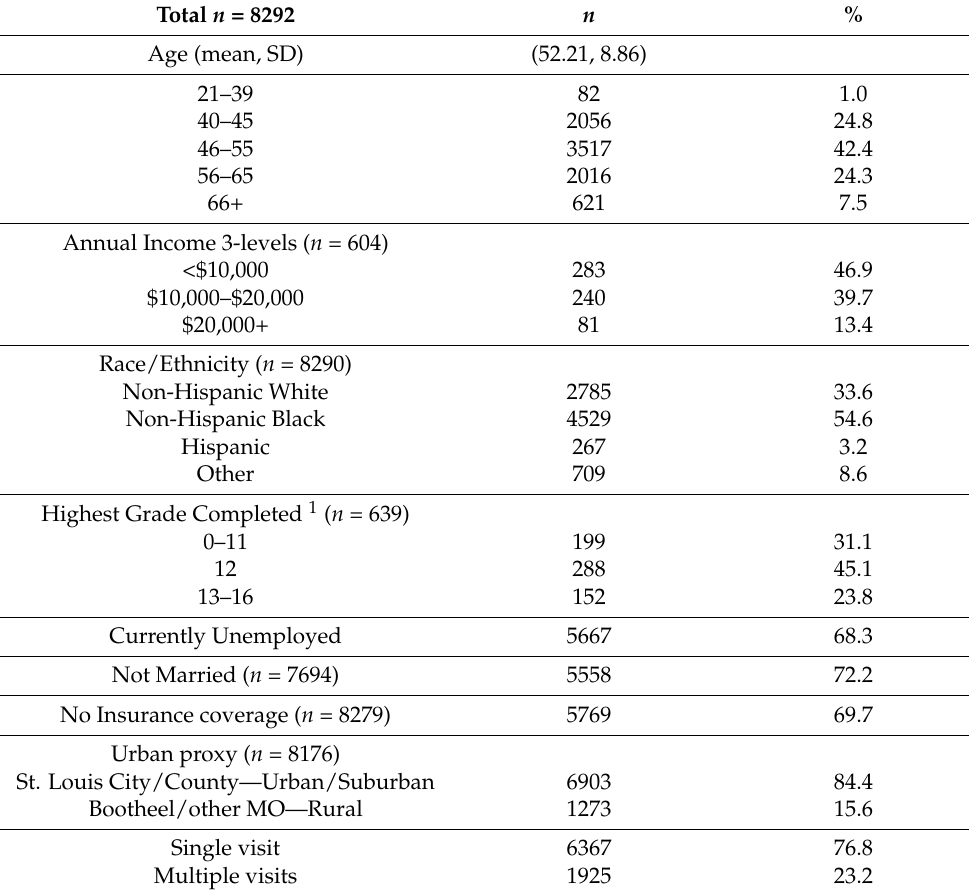
Table 2. Demographic characteristics of